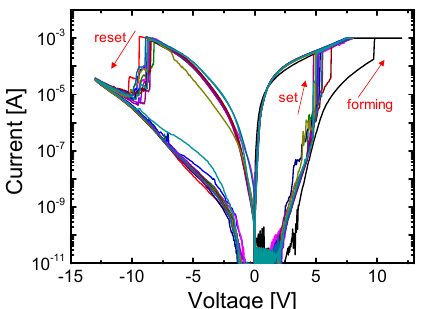
Figure 3. DC I-V bipolar resistive characteristics of the Ni/SiN x /n + Si RRAM device.